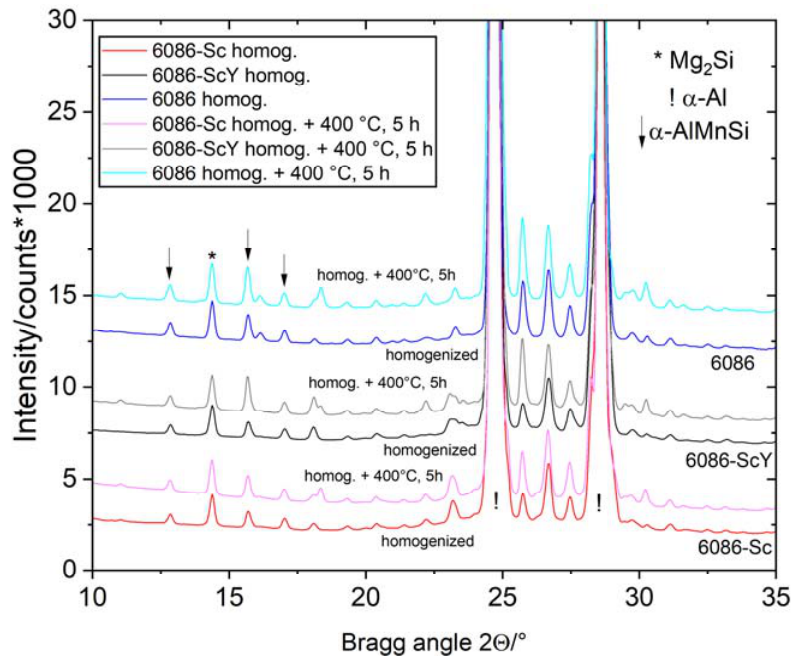
Figure 9. The results of analytical TEM of a particle with the L1 2 structure. After homogenization: ( a ) 6086-Sc, ( b ) 6086-ScY; and after homogenization and heat treatment at 400 °C for 5 h: ( c ) 6086-Sc and ( d ) 6086-ScY.